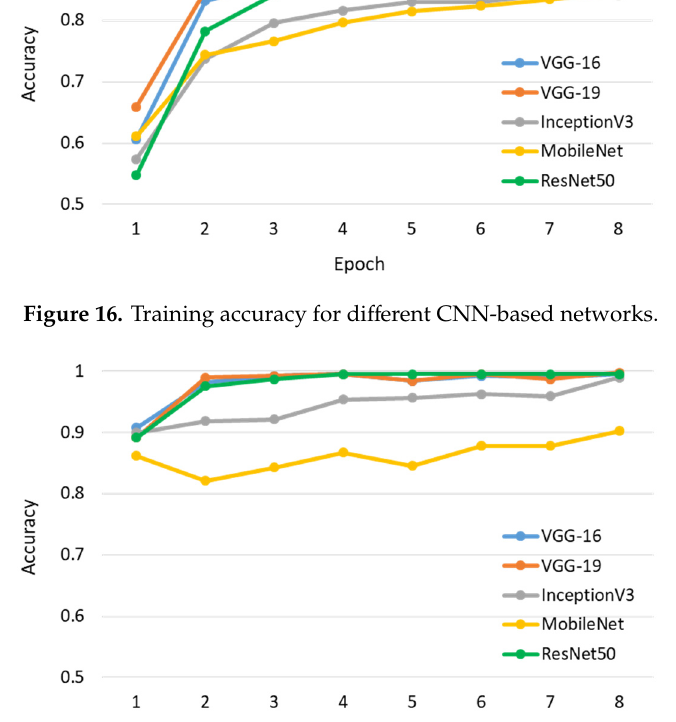
Table 6. Comparison of different models for pattern classification.